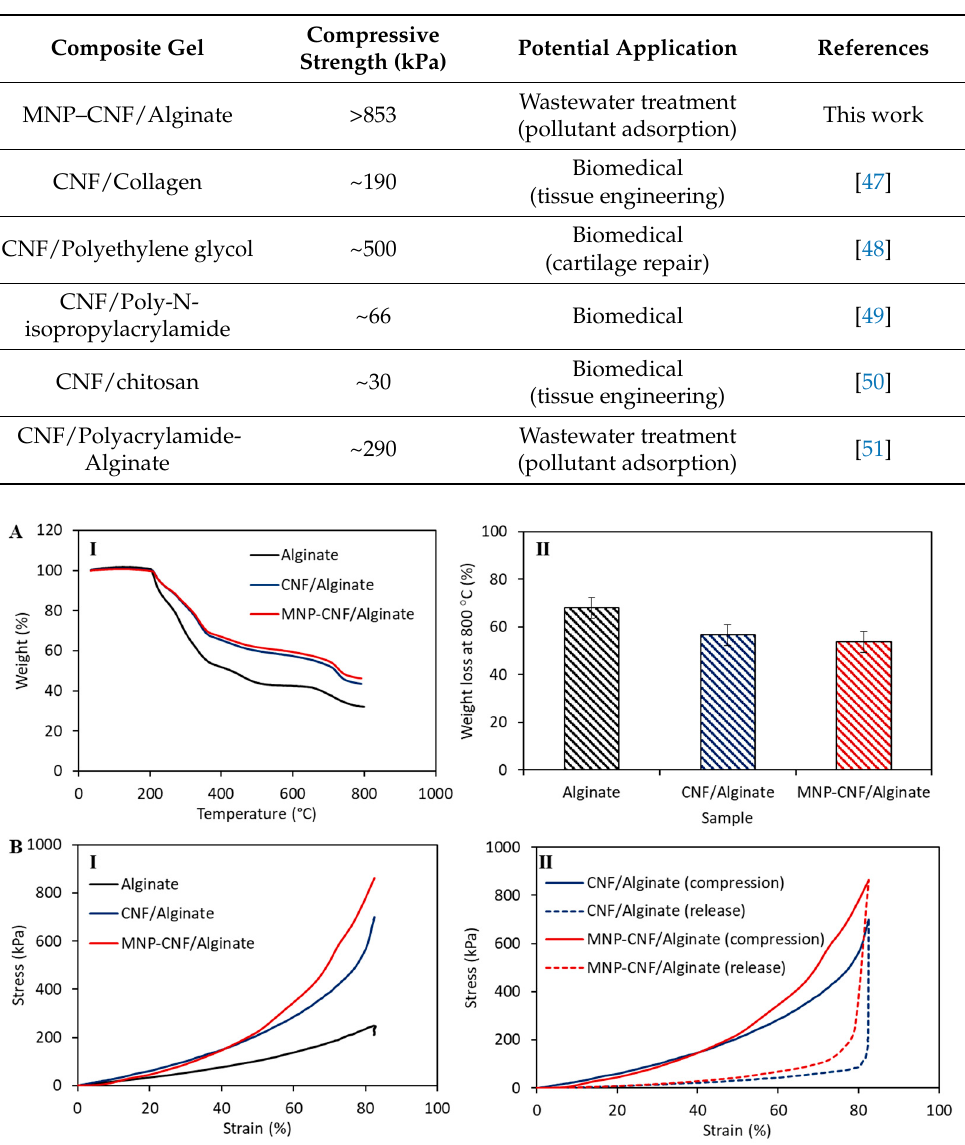
Table 1. Comparative compressive strength and application fields of MNP–CNF/alginate beads with some previously published research.